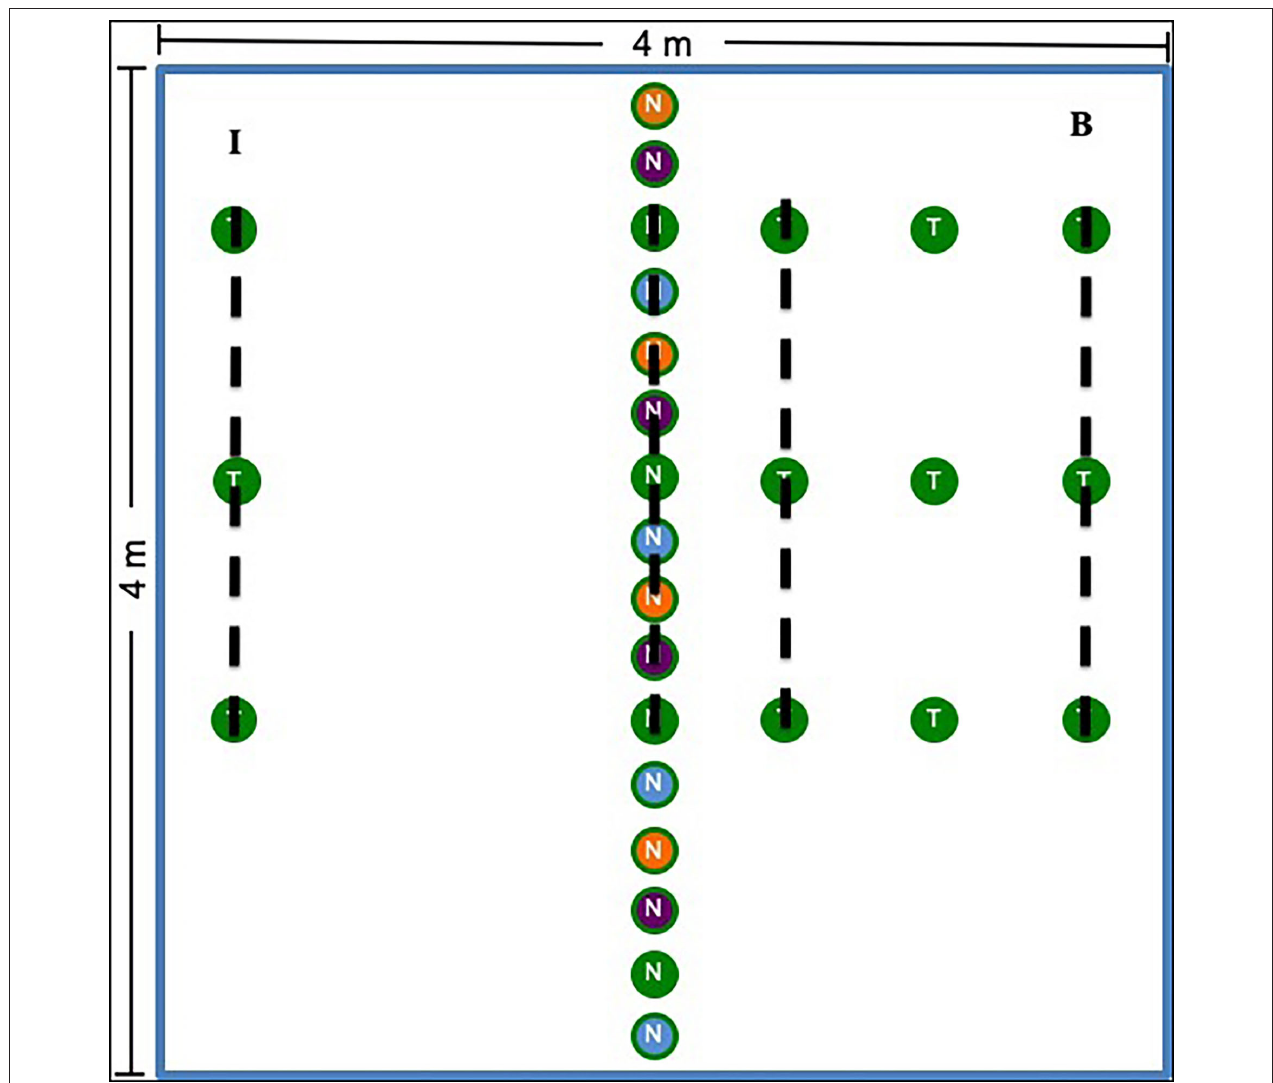
FIGURE 1 | Plot design for the experiment. The center row represents the nurse plant row, which was either inoculated with whole prairie soil, prairie AMF only, or sterilized control soil (non-inoculated) depending on the plot treatment. The colors represent species. Four species were used as nurse plants. In Chanute and Tinker, test plants ( S. scoparium at Chanute and A. gerardii at Tinker) were planted in rows 0.5-, 1-, and 2-m away from the nurse plant row. On one side, only the 2-m plants were added (I), whereas on the other side (B), plants were placed at 0.5-, 1-, and 2-m away from the nurse plant row. The dotted lines represent where soil and root samples were taken for molecular analysis. Plant community data were collected 0.5-, 1-, and 2-m away from the nurse plant row, and the side on which these data were taken was selected randomly each year and varied by